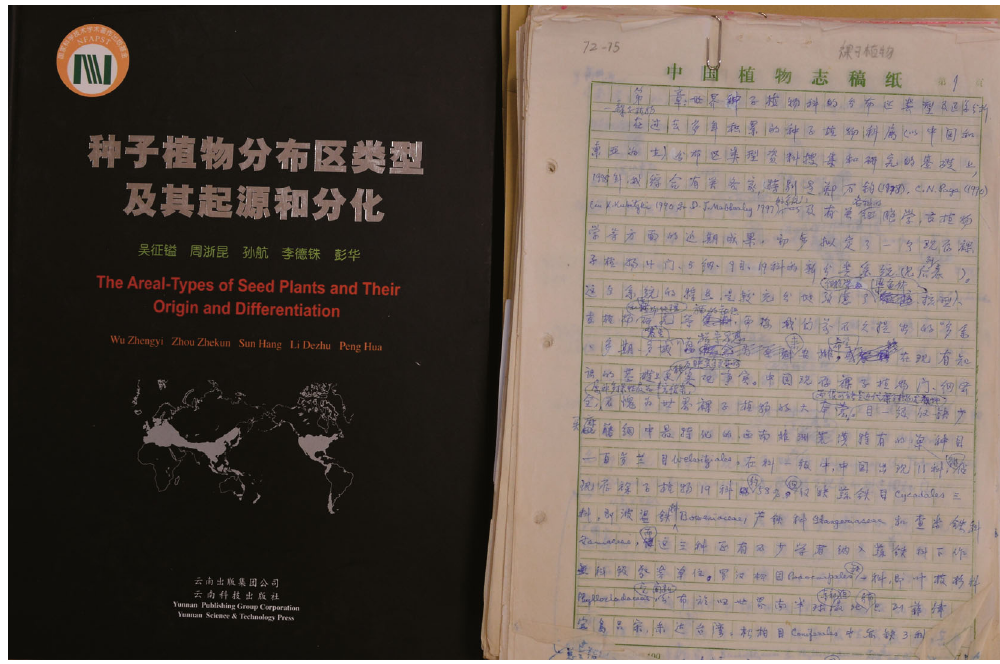
Figure 4. The book and manuscript of Professor Zhengyi